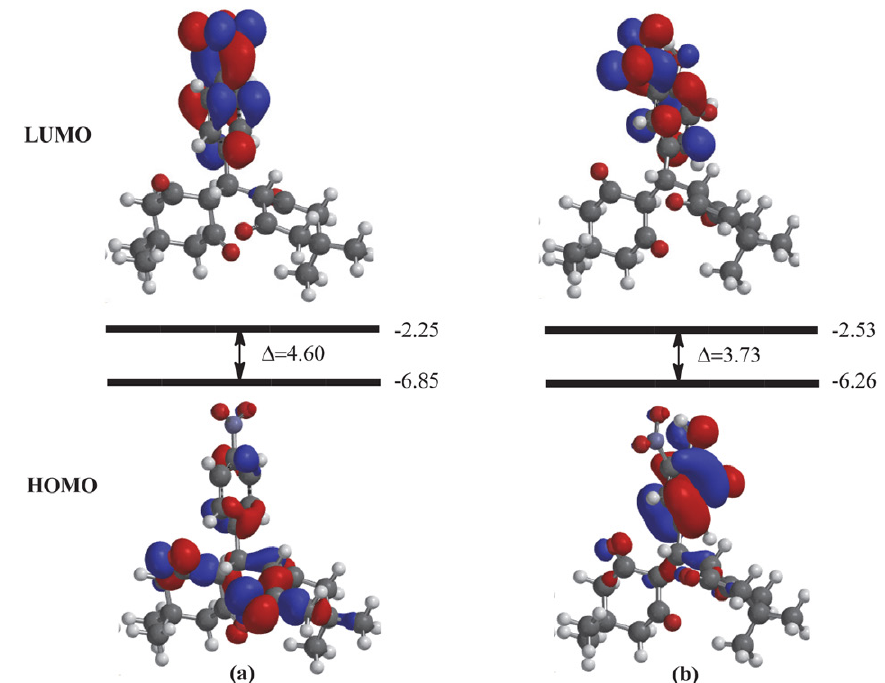
Figure 9. Frontier molecular orbitals of compound 1 ( a ) and compound 2 ( b ). All values are in